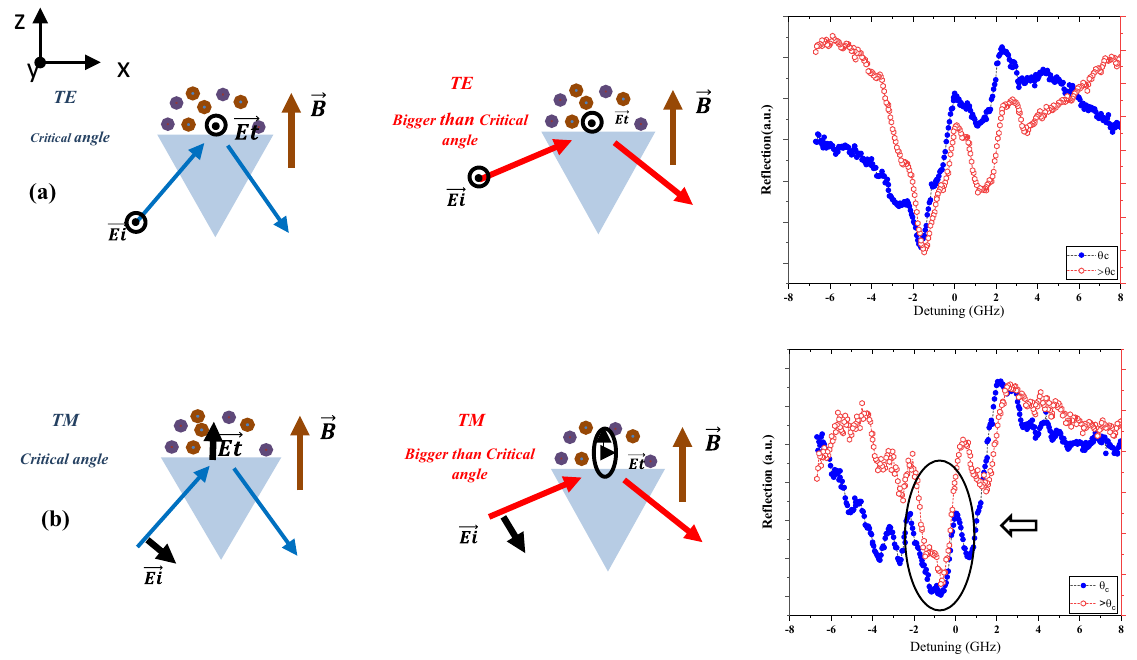
Figure 4. Results of evanescent wave reflection, ( a ) comparison of s polarization at a critical angle and 7 degrees larger than the critical angle, ( b ) comparison of p polarization at a critical angle and 7 degrees larger than the critical